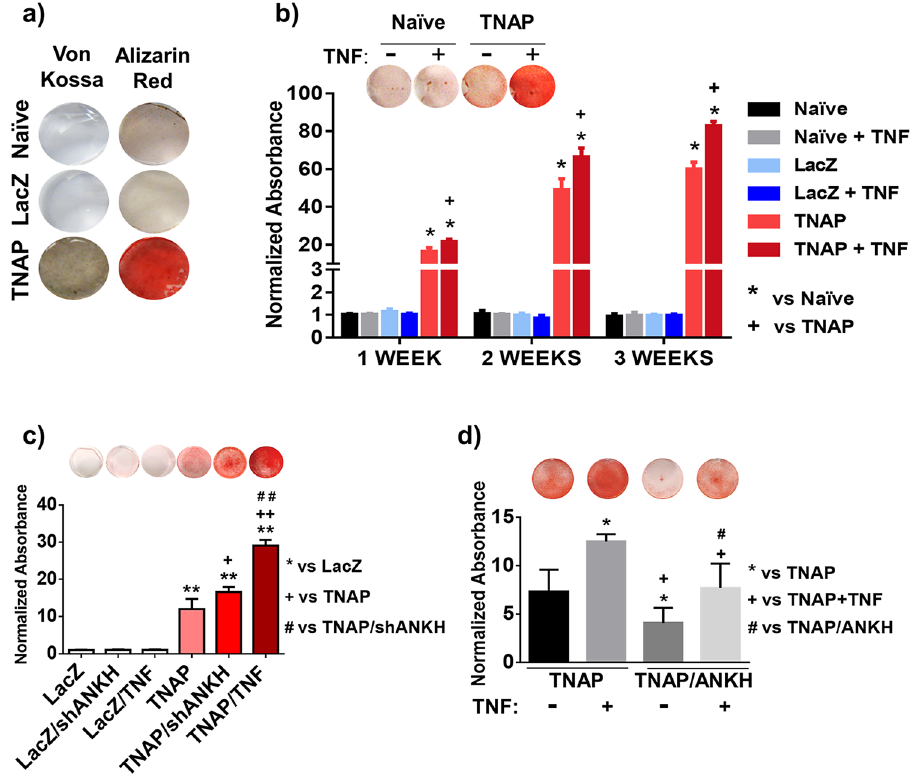
Figure 2. TNF increases mineral deposition in bNP cells. ( a ) Representative image of Alizarin red and von Kossa stained cells: no staining in naïve or LacZ transduced cells. Positive staining in TNAP transduced cells after 3 weeks of incubation in mineralizing medium (n = 3); ( b ) representative image of Alizarin red staining (1 week) and spectrophotometric quantifications of the staining. Increase of mineral deposition observed in cultures of TNAP-transduced bNP cells treated with 20 ng/mL of TNF (n = 4); ( c ) representative image of Alizarin red staining and spectrophotometric quantifications of the staining (1 week). Increase of mineral deposition observed in TNAP/shANKH and TNAP/TNF double transduced bNP cells compared to TNAP single transduced cells (n = 3–5); ( d ) representative image of Alizarin red staining and spectrophotometric quantifications of the staining (1 week). A decrease in mineralization and reduction of TNF-induced mineral deposition when the ANKH gene is over-expressed in TNAP cells (n = 3–5). Significance represents *p < 0.05 or **p < 0.005. Data analyzed using one-way